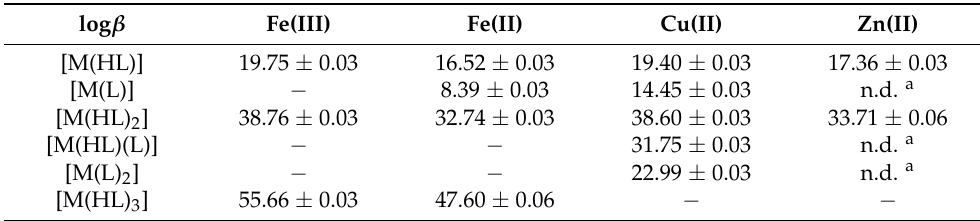
Table 2. Formation constants (log β ) of the Fe(III), Fe(II), Cu(II) and Zn(II) complexes with HQNO 2 -L-Pro determined by UV-vis spectrophotometric titrations. (H 2 L is the neutral form of the ligand, charges of the complexes are omitted for clarity.) { I = 0.1 M (KCl); t = 25.0 ◦ C}.